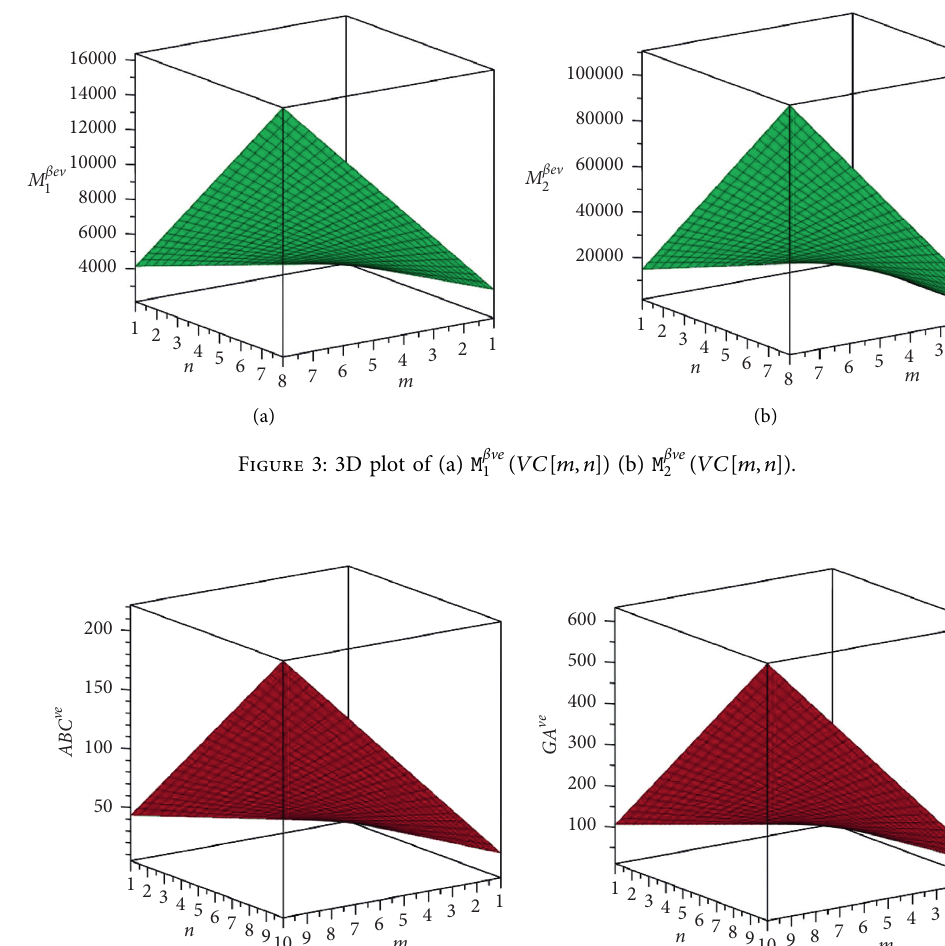
Figure 4: 3D plot of (a) ABC ve ( VC [ m, n ]) (b) GA ve ( VC [ m, n ]) .